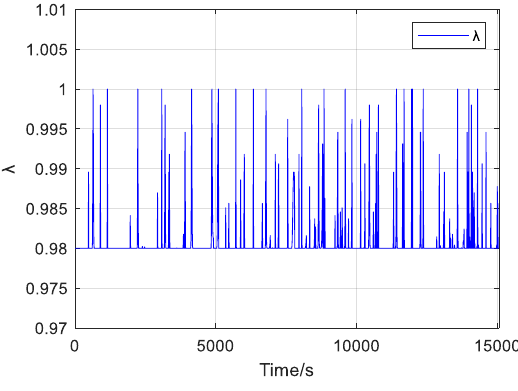
Figure 10. Adaptive forgetting factor λ .